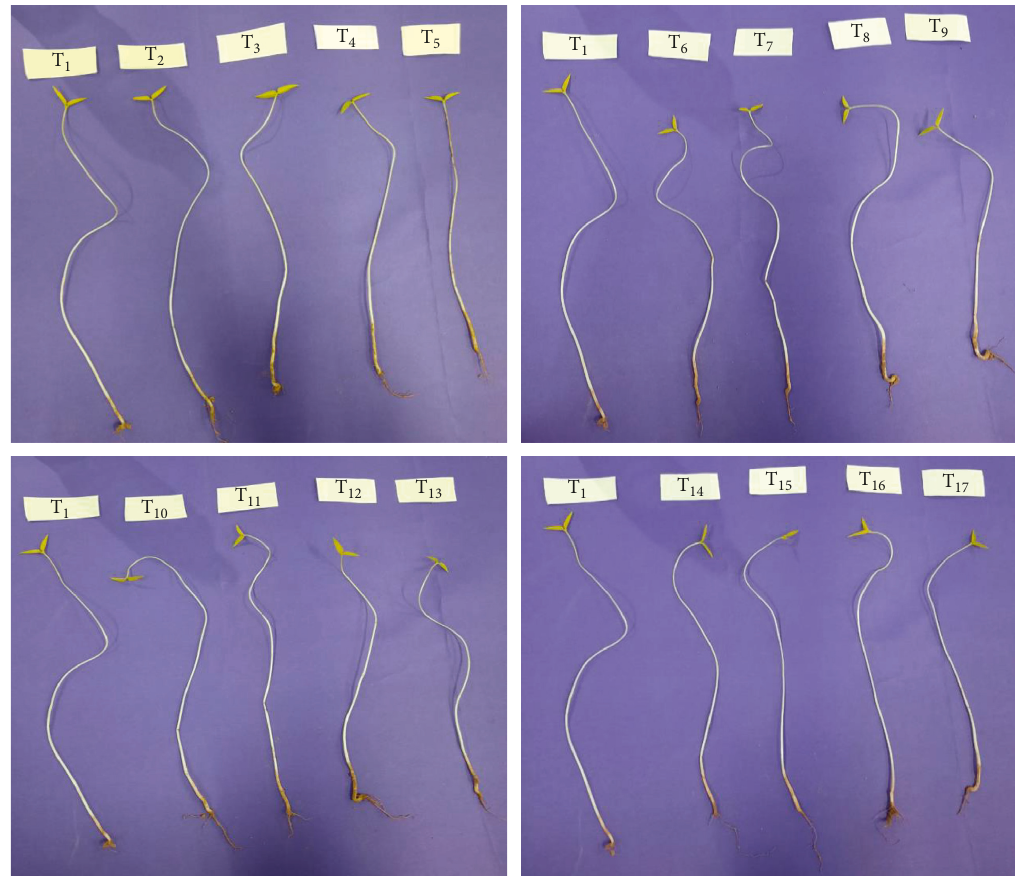
Figure 3: Impact of biosorbed water by various biosorbents (orange peels, pomegranate peels, and peanut peels) on the growth of mung bean after 7 days of seed germination. T1, negative control; T2, 50mg kg − 1 ; T3, pomegranate peel biosorbed water +50mg kg − 1 ; T4, peanut peel biosorbed water +50mg kg − 1 ; T5, orange peel biosorbed water +50mg kg − 1 ; T6, 100mg kg − 1 , T7, pomegranate peel biosorbed water +100 mg kg − 1 ; T8, peanut peel biosorbed water +100 mg kg − 1 ; T9, orange peel biosorbed water +100 mg kg − 1 ; T10, 150mg kg − 1 ; T11, pomegranate peel biosorbed water +150 mg kg − 1 ; T12 peanut peel biosorbed water +150 mg kg − 1 ; T13, orange peel biosorbed water +150 mg kg − 1 ; T14, 200mg kg − 1 ; T15, pomegranate peel biosorbed water +200 mg kg − 1 ; T16, peanut peel biosorbed water +200 mg kg − 1 ; T17, orange peel biosorbed water +200 mg kg − 1 Vertical bars (I): standard error (mean of 3 replicates). Alphabets on vertical bars: significant difference ( P ≤ 0 . 05) evaluated by the LSD